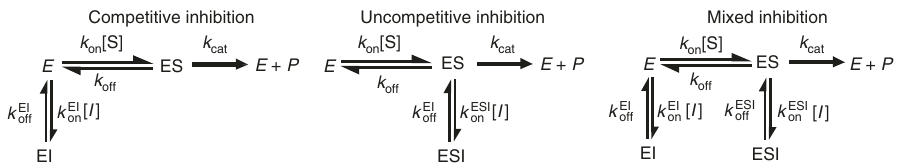
Fig. 1 The three canonical modes of enzymatic inhibition. From left to right: competitive, uncompetitive, and mixed inhibition. Rates govern transitions between the different states: free enzyme ( E ), enzyme – substrate complex (ES), enzyme – inhibitor complex (EI), enzyme – substrate – inhibitor complex (ESI), and the ( E + P ) state which represents the end of a turnover